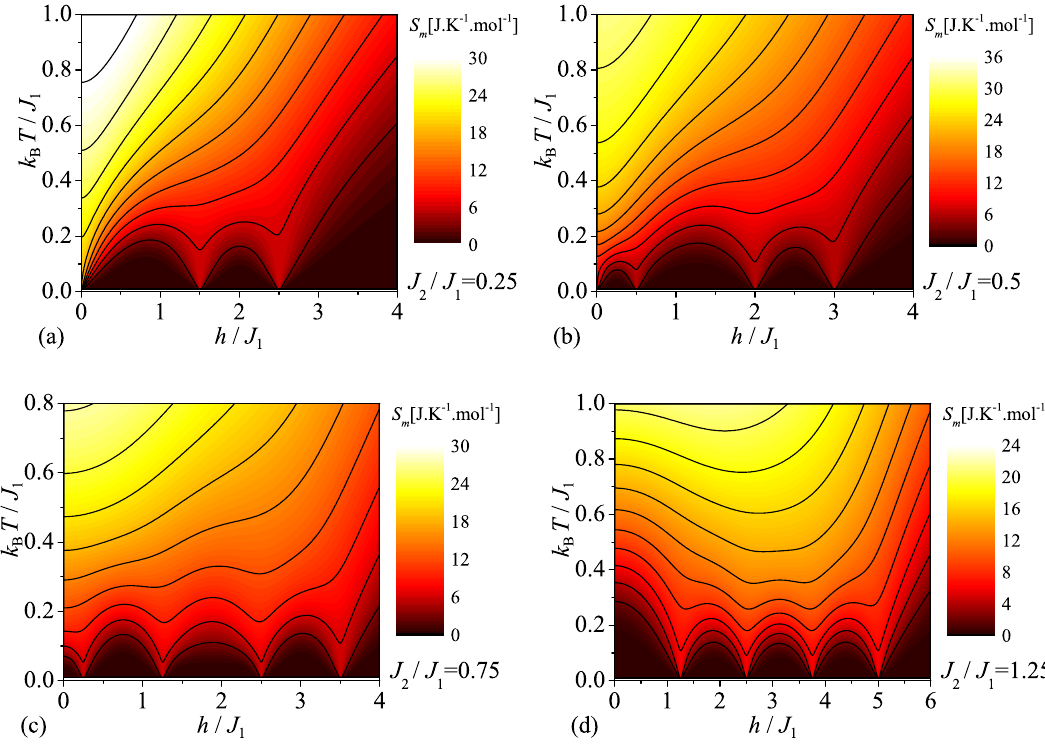
Figure 6. A density plot of a magnetic part of the molar entropy S m in J · K − 1 · mol − 1 units in the magnetic field versus temperature plane for four different values of the interaction ratio: ( a ) J 2 / J 1 = 0.25; ( b ) J 2 / J 1 = 0.5; ( c ) J 2 / J 1 = 0.75; ( d ) J 2 / J 1 =